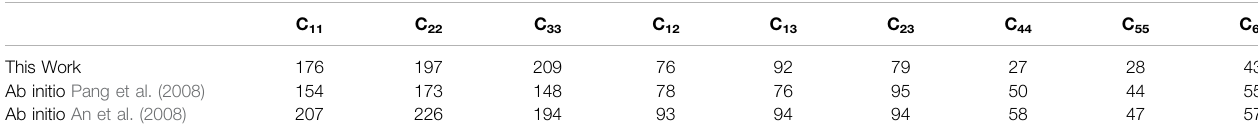
Frontiers in Materials |